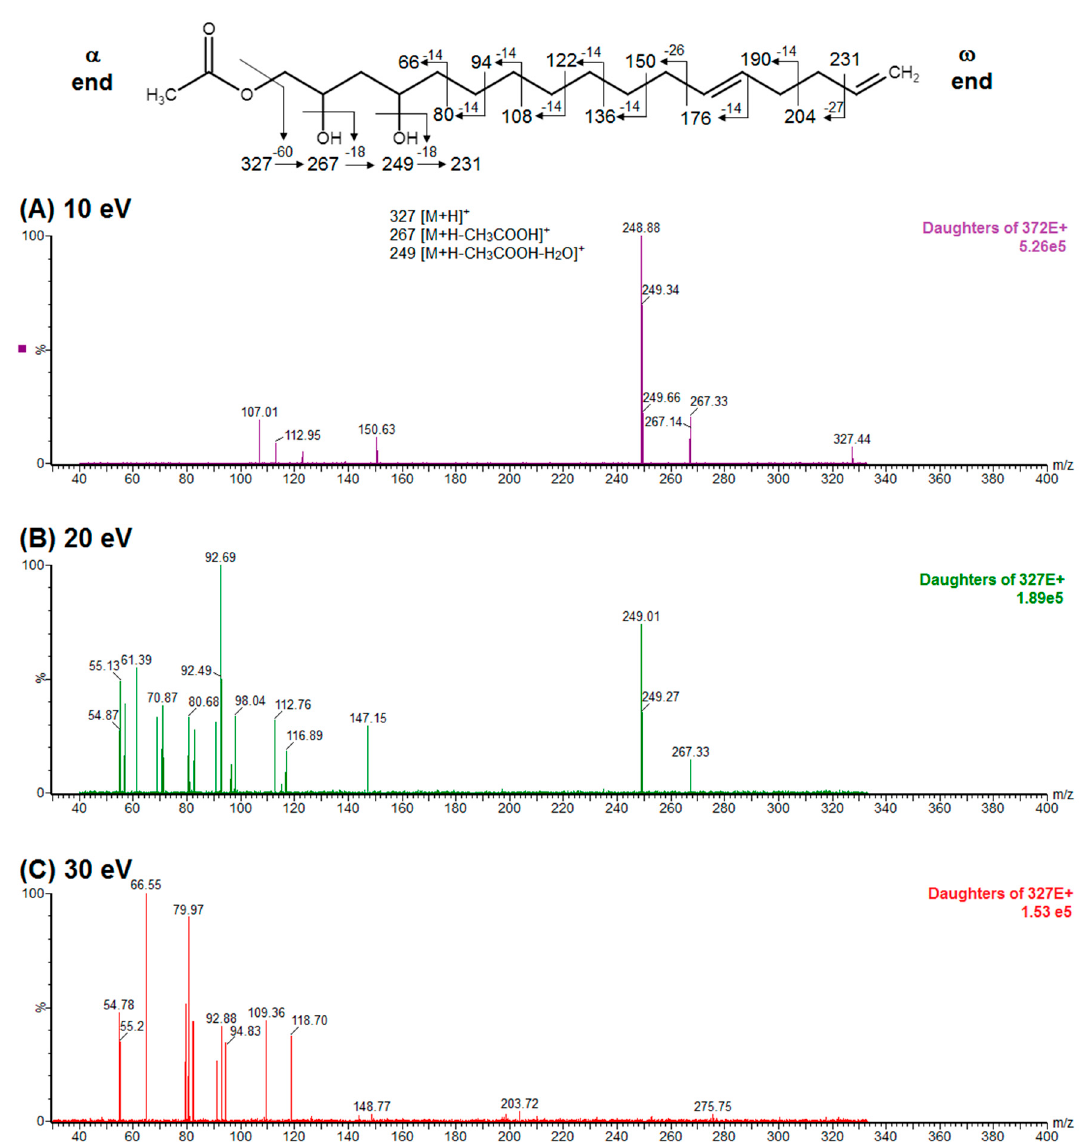
Figure 3. ESI-MS / MS spectra of AcO-avocadiene B (labeled as compound 3 in Table 1 and Figure 1) obtained by collision-induced dissociation (CID) of the precursor ion at m / z 327 and daughter ion at m / z 249. Data shown in panels are for collision energies of ( A ) 10 eV, ( B ) 20 eV, and ( C ) 30 eV. Note: “ α end” refers to the charged side of the molecule that corresponded to oxygenated functional groups, whereas “ ω end” refers to the methyl end.